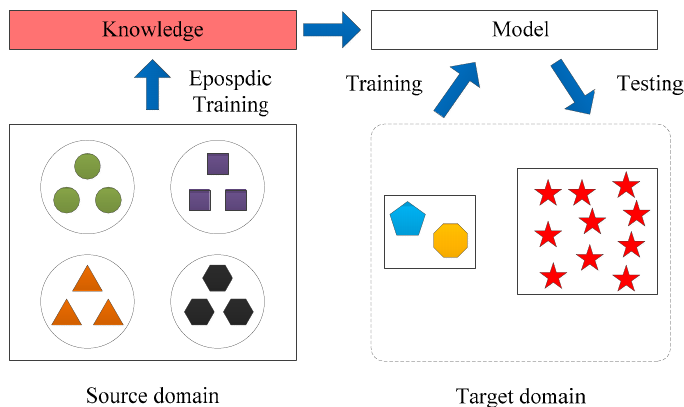
Figure 2. General procedure of Few-shot learning.